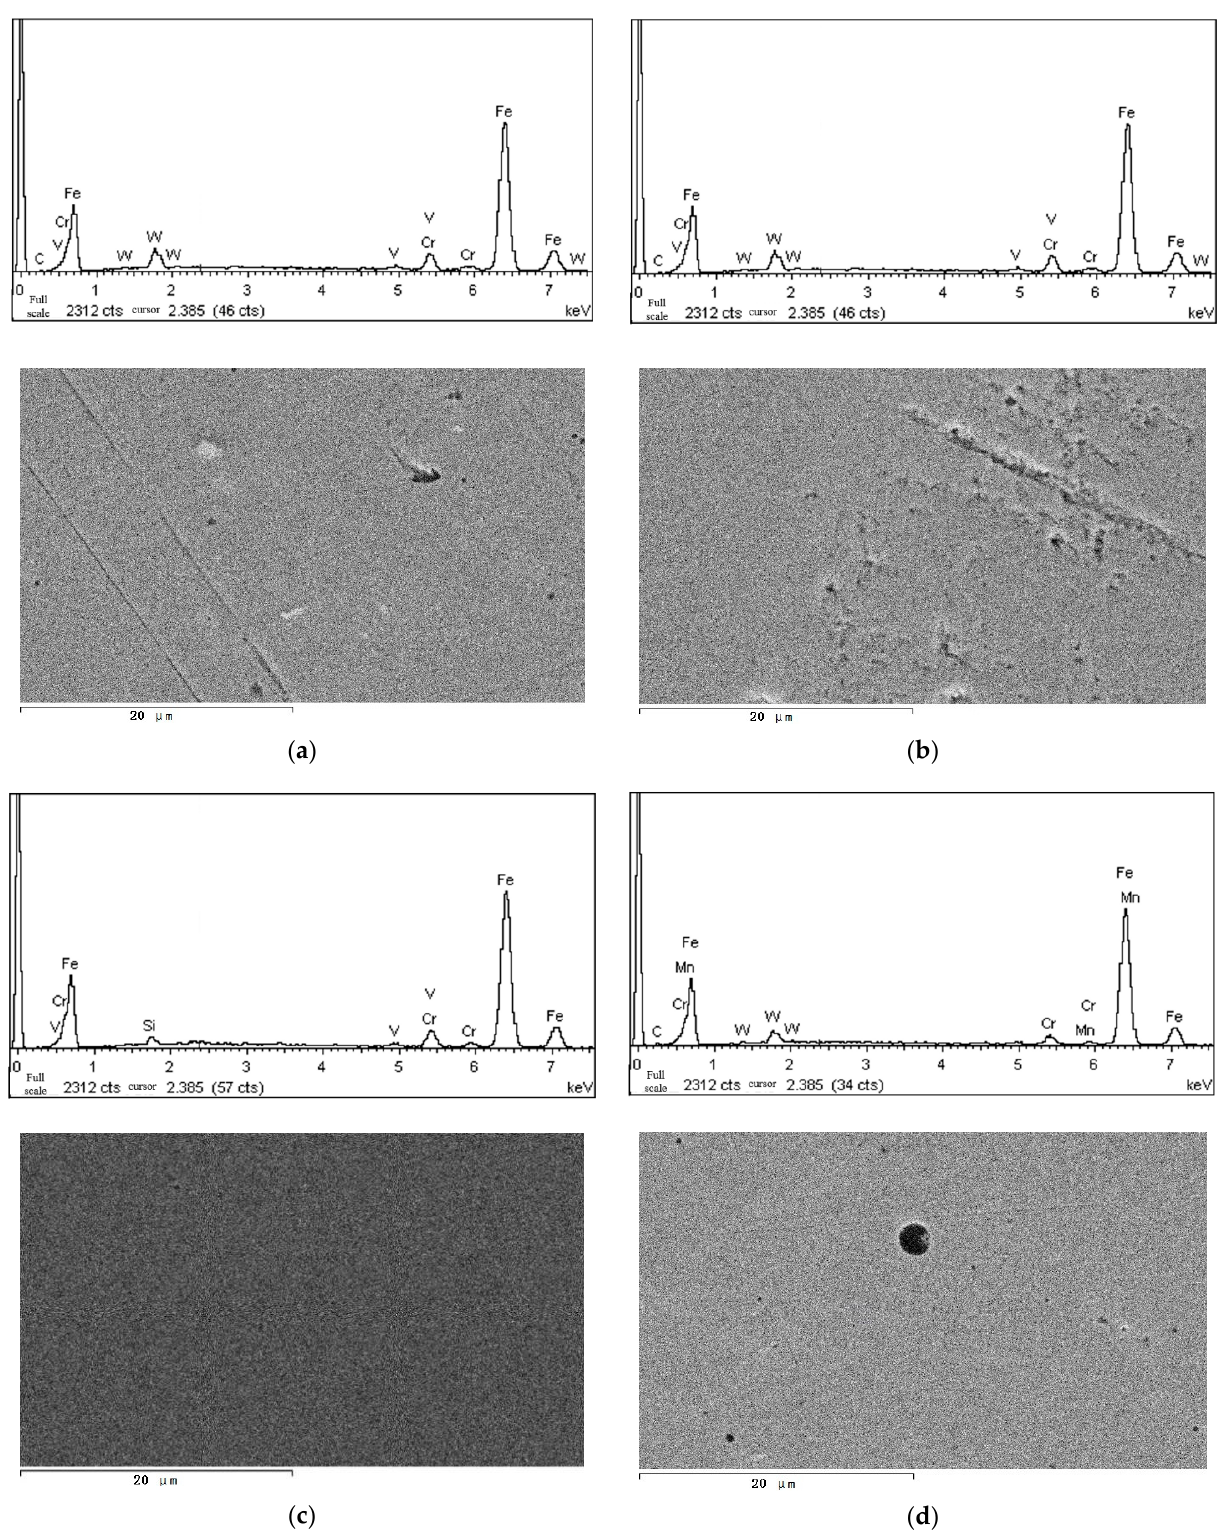
Figure 9. EDS analysis measured map. ( a ) Point A; ( b ) Point B; ( c ) Point C; ( d ) Point D.